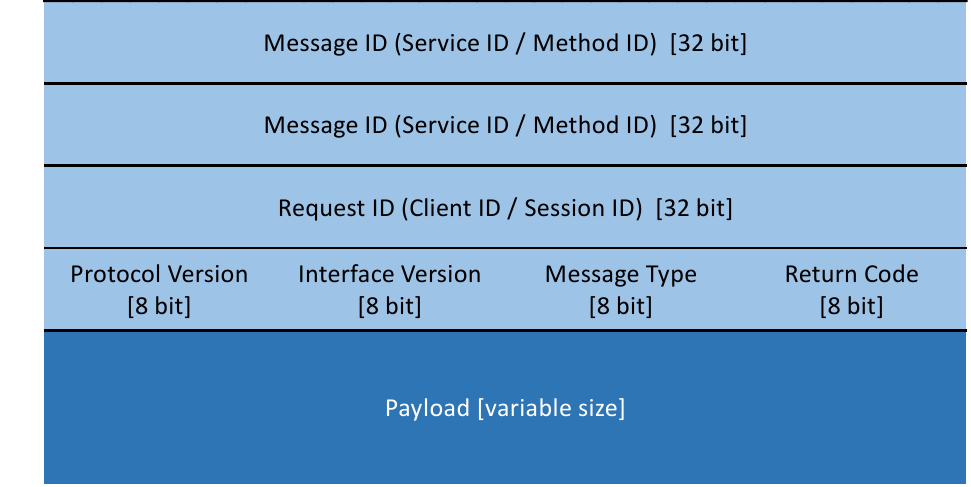
Figure 4. SOME/IP frame structure.